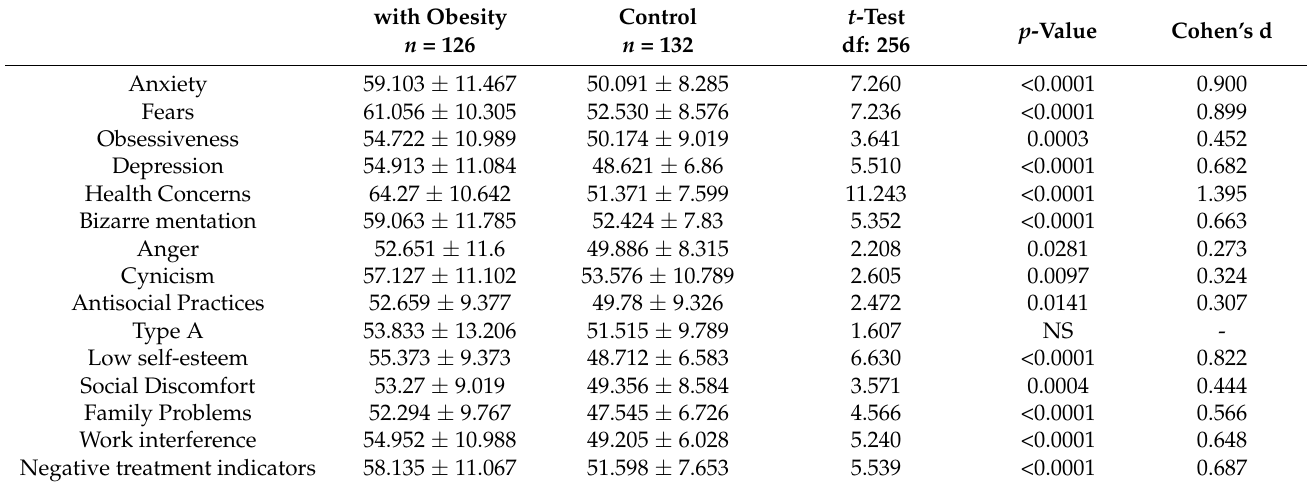
Table 2. Mean differences in Content Scale of the MMPI-2 test between the mothers of children with and without